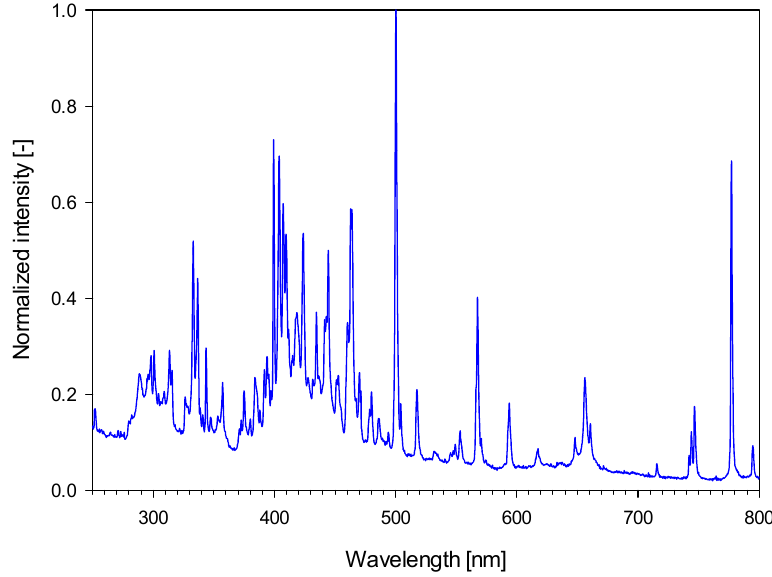
Figure 5. Electric arcs with forced ventilation (air replacement with fresh air). Normalized spectra of electric arcs with 50 Hz ac supply at 43 kV using a needle-plane gap (diameter = 3.5 mm, gap = 70 mm).